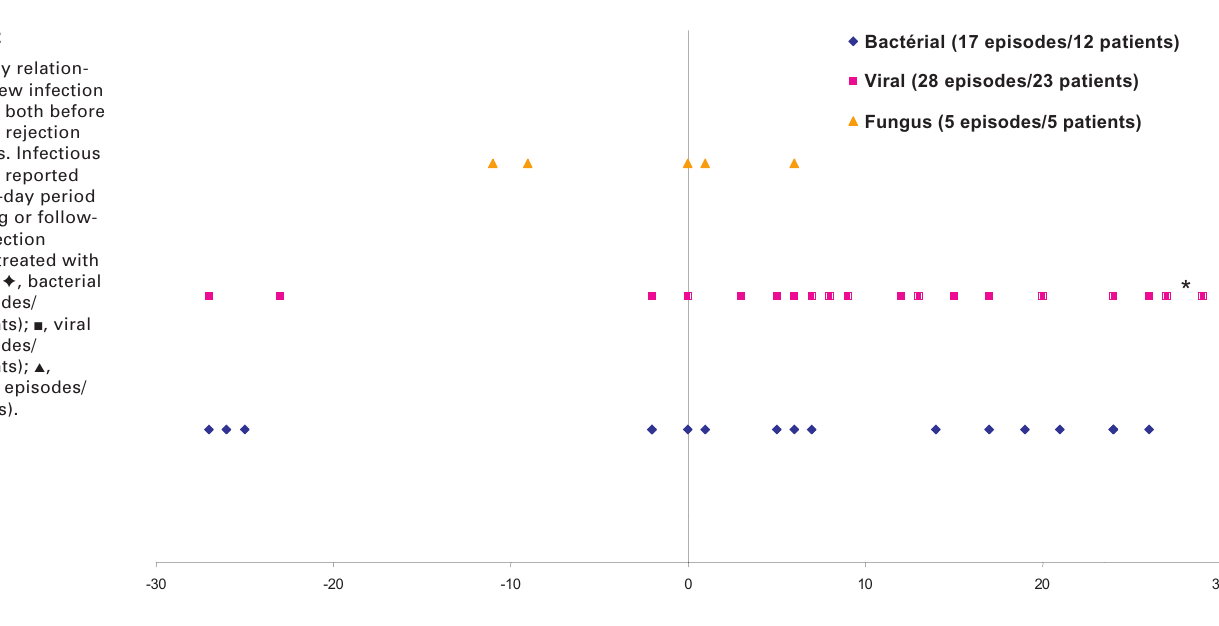
Viral (28 episodes/23 patients) Fungus (5 episodes/5 patients)